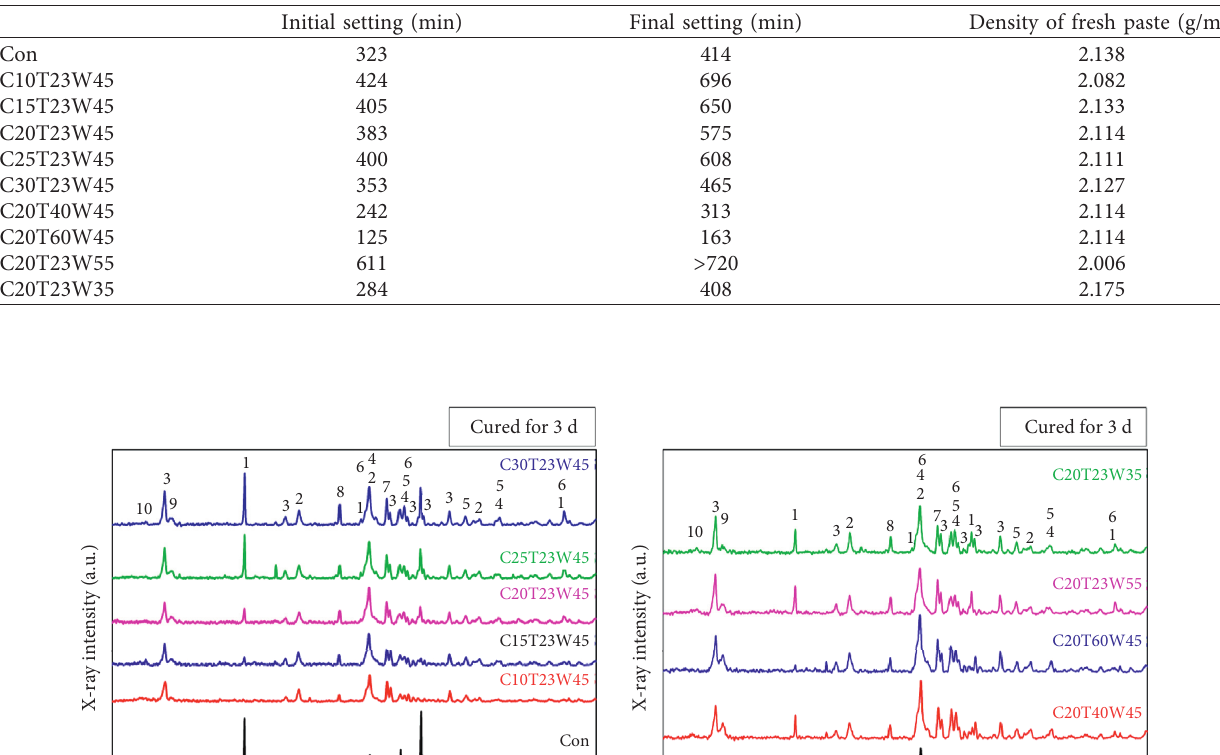
3 S, (5) C 2 S, (6) CSH (I), (7) gehlenite, (8) quartz,